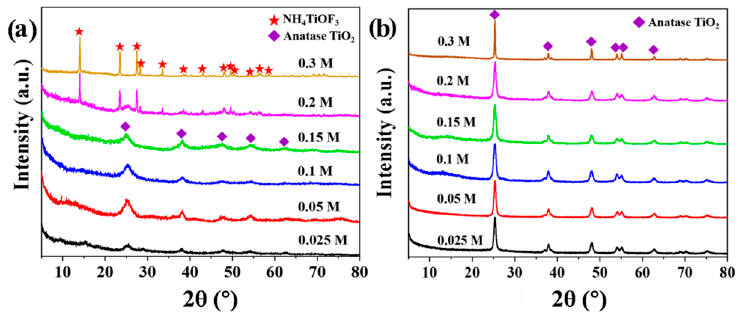
Figure 4. SEM images of the samples prepared with different (NH 4 ) 2 TiF 6 concentrations before calcination: ( a ) 0.05 M, ( b ) 0.1 M, ( c ) 0.15 M, ( d ) 0.2 M, ( e ) 0.3 M. ( f ) The thickness data of the samples.